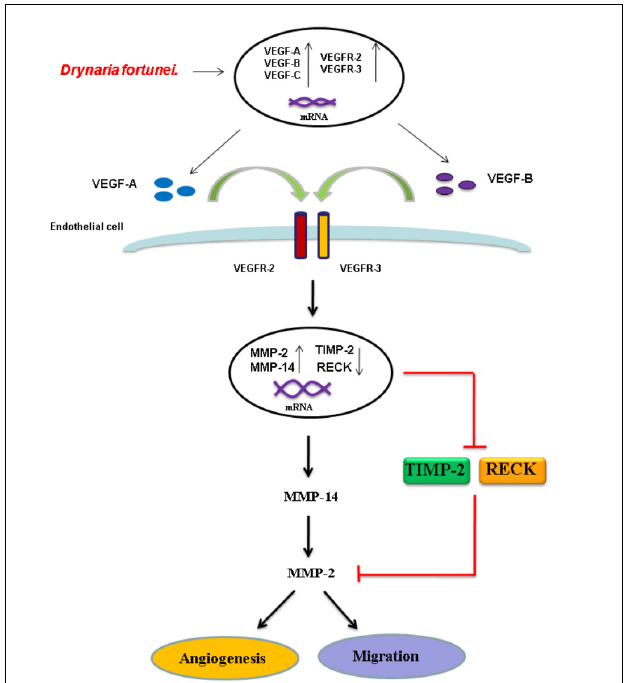
FIGURE 9 | Schematic diagram of D. fortunei- induced angiogenesis through modulation of MMP-2/TIMP-2 balance and activation of VEGF ligand/receptors